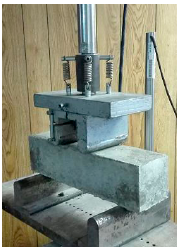
Figure 5. The flexural strength test setup.